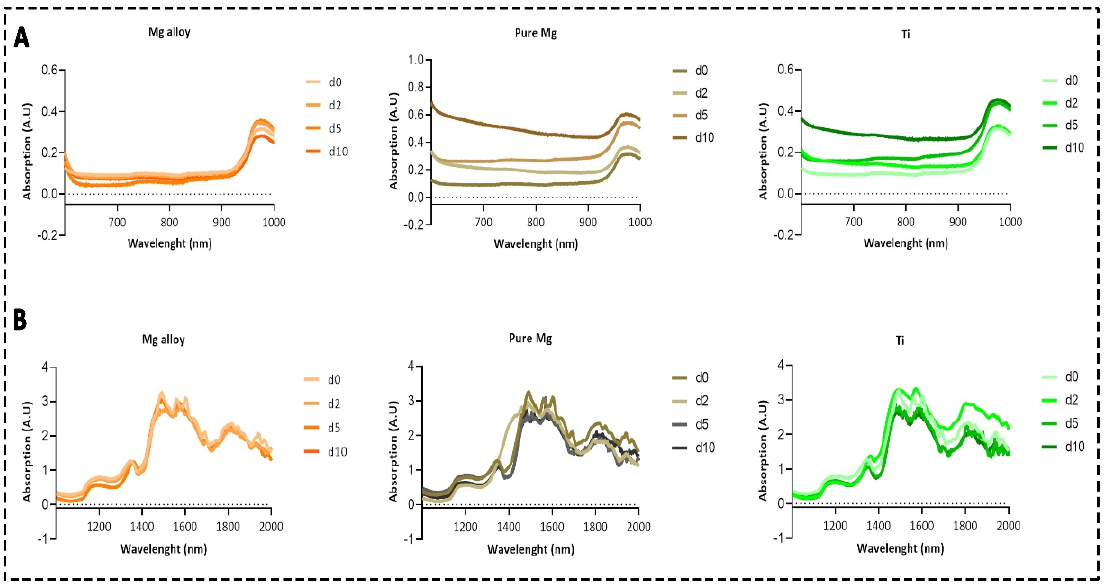
Figure 1. The absorption spectra of DMEM solution containing Mg alloy, pure Mg, and Ti. ( A ) Avantes spectrometer within 600 and 1000 nm; ( B ) results of the NIRQuest Spectrometer from 1000 to 2000 nm.